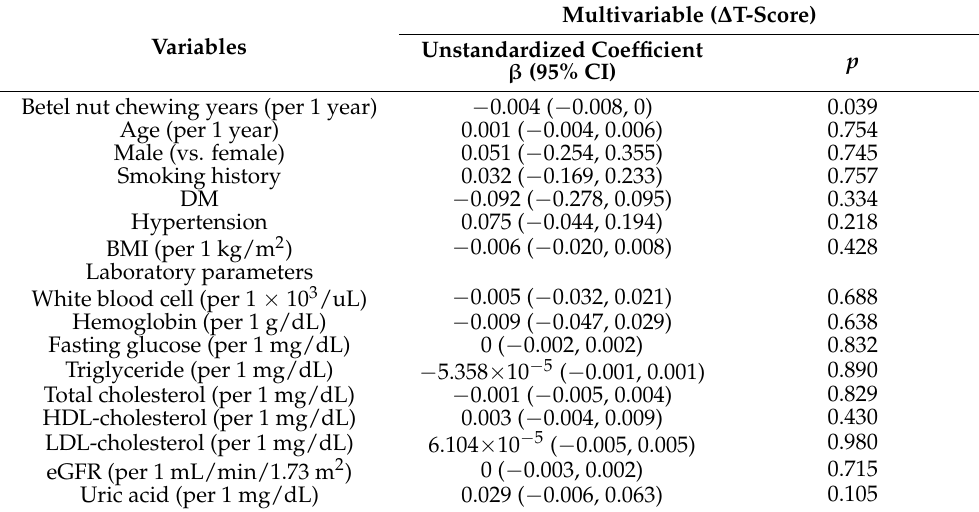
Table 4. Association of betel nut chewing years with calcaneus ultrasound ∆ T-score in study partici- pants with betel nut chewing history ( n = 1778) using multivariable linear regression